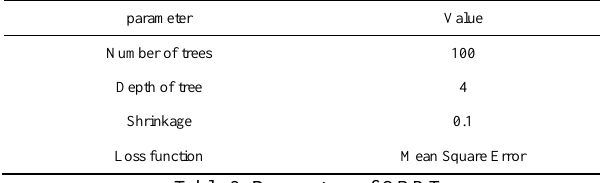
Table 3. Parameters of